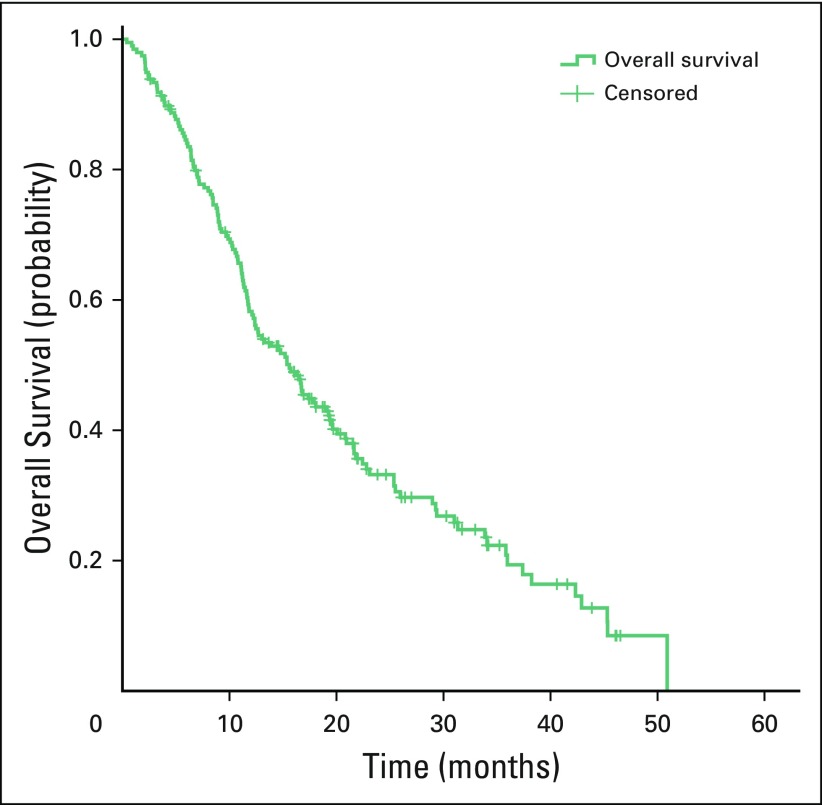
Kaplan-Meier curve for overall survival of the whole cohort (15.6
months).